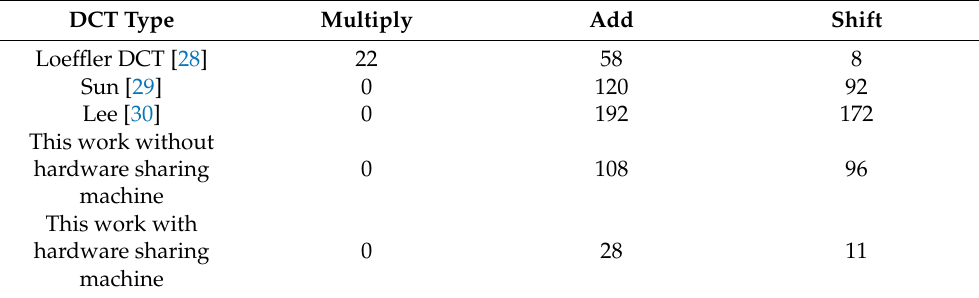
Table 5. Comparison of computing resources of previous DCT algorithms and this work showing the multiply, add, and shift